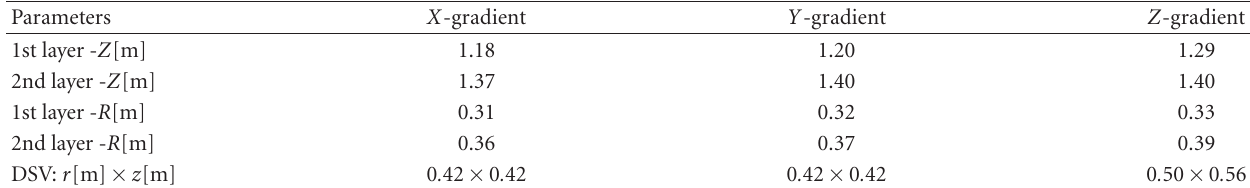
Table 1: Geometrical properties of gradient coils.